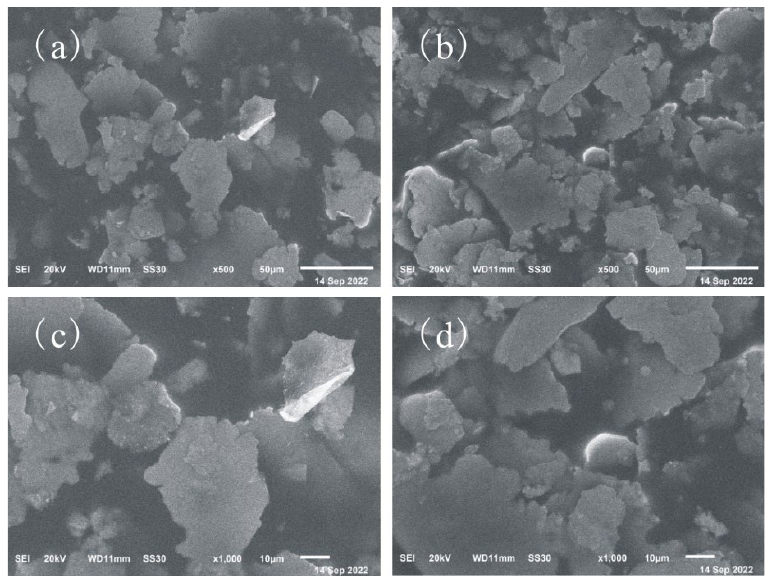
Figure 6. SEM images of coatings with contents of dispersant of 0 wt% ( a , c ) and 9 wt% ( b , d ). Table 4. Performance index of coatings with different addition amounts of